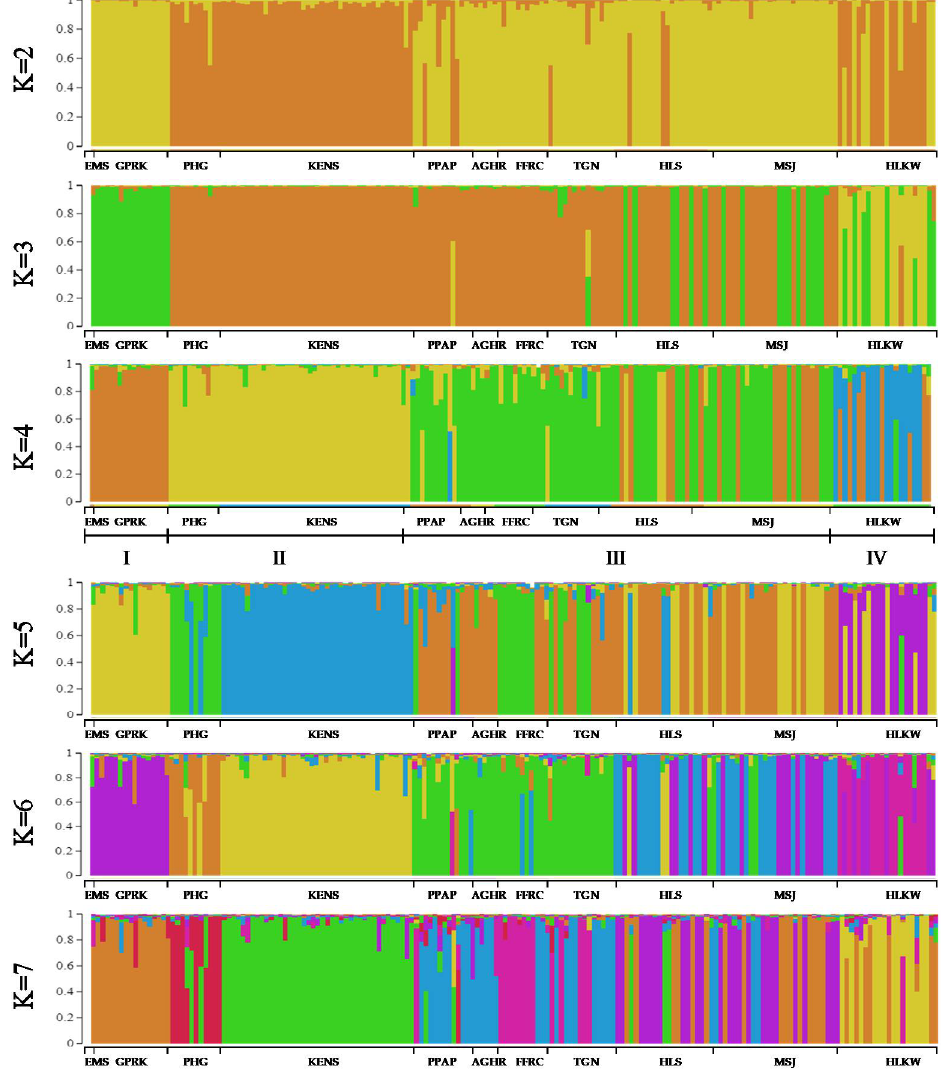
Figure 4. Population structure of the Tor spp. individuals collected from eleven populations estimated according to the Bayesian model by the STRUCTURE program Version 2.3.4 for K = 2–7 based on 22 microsatellite loci. Different colours indicate different genetic clusters: EMS: Empurau, Sarawak; GPRK: Grik, Perak; PHG: Raub, Pahang; KENS: Kg Esok, Jelebu, Negeri Sembilan; PPAP: Aquaculture Extension Center, Perlok, Jerantut, Pahang; AGHR: AgroHarvest, Raub, Pahang; FFRC: FRIGL stock (collected during FFRC Batu Berendam, Melaka); TGN: Terengganu; HLS: Hulu Langat, Selangor; MSJ: Mersing, Johor; HLKW: Kelah World, Hulu Langat, Selangor. At K = 4, the eleven populations of Tor spp. were unambiguously divided into four groups with unique and distinct genetic compositions corresponding to the respective geographical regions. The four different groups were: (I) EMS, GPRK (Northern); (II) PHG, KENS (East Coast, Pahang River); (III) PPAP, AGHR, FFRC, TGN, HLS, MSJ (East Coast, Terengganu River); and (IV) HLKW (Indonesia). All members in EMS, GPRK (group I), PHG, KENS (group II), and AGHR, FFRC, and TGN (group III) were correctly assigned to their respective populations. Nevertheless, some of the individuals in both the HLS and MSJ populations of group III were assigned to group I (30% members of HLS and 35.7% members of MJS, respectively). Individuals in the PPAP and TGN populations, 76.9% and 92.9%, respectively, were assigned to group III. Some members in the PPAP population had admixed ancestry with group II and group IV, while 7.1% of the members in the TGN population had admixed ancestry with group IV. Meanwhile, some members in the